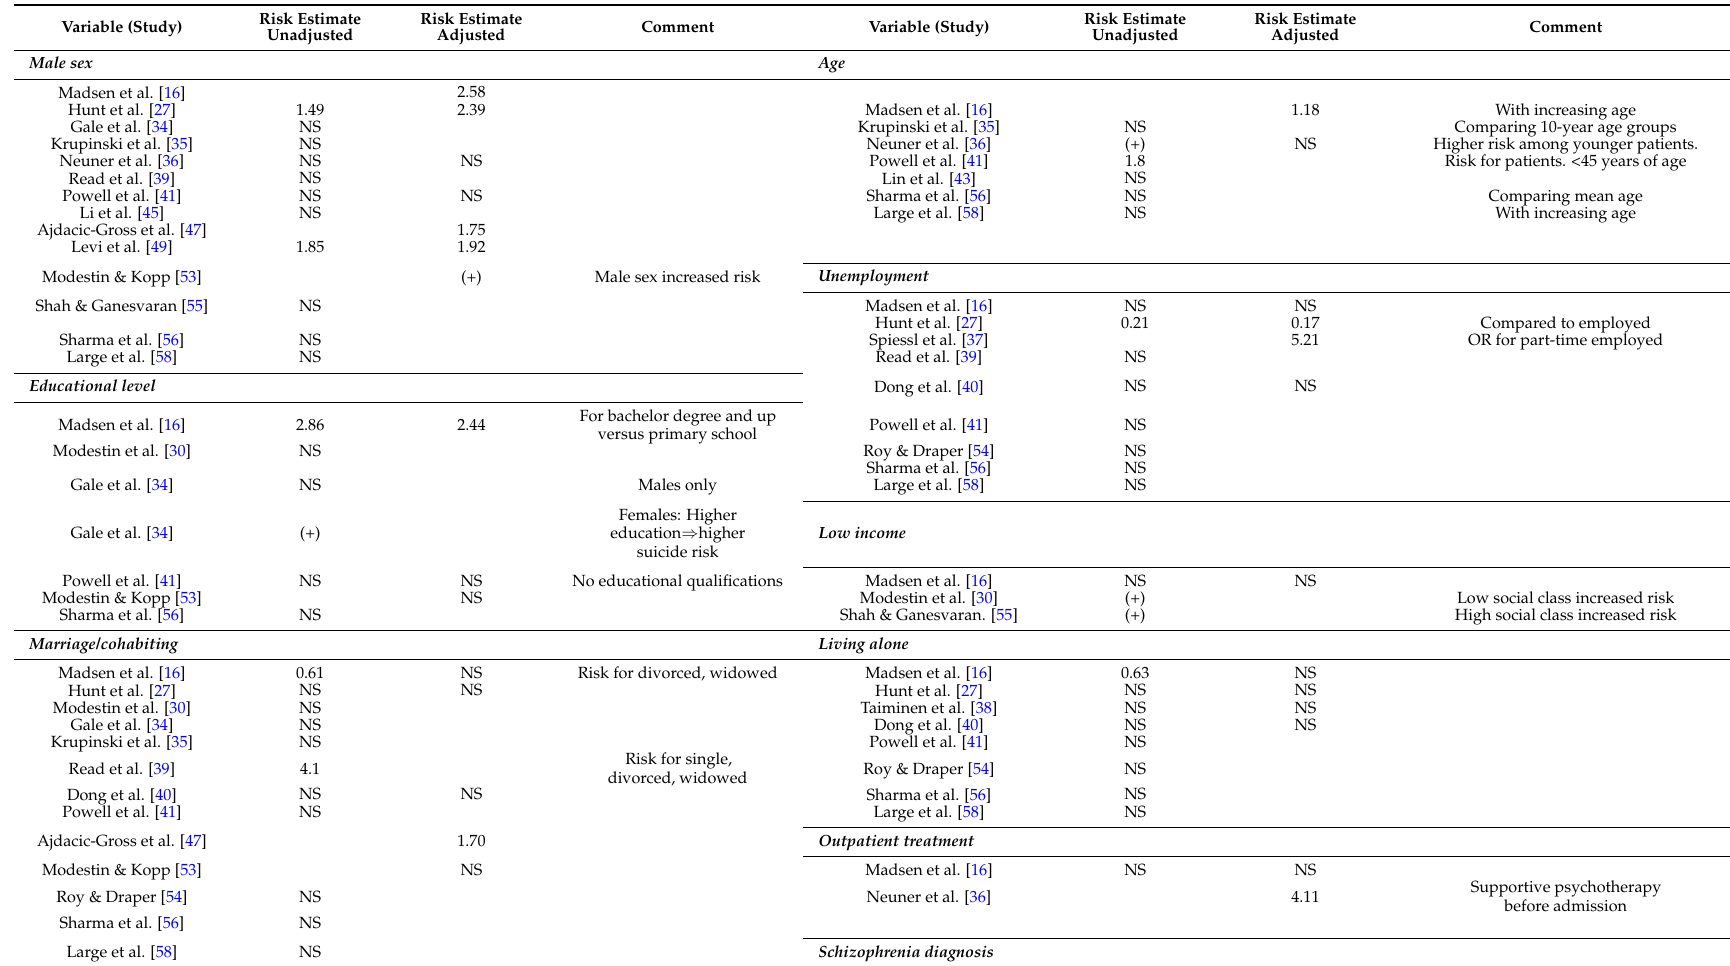
Table 3. Outline of examined predictors for inpatient suicide. Reported risk estimates are all significant with a p -value below